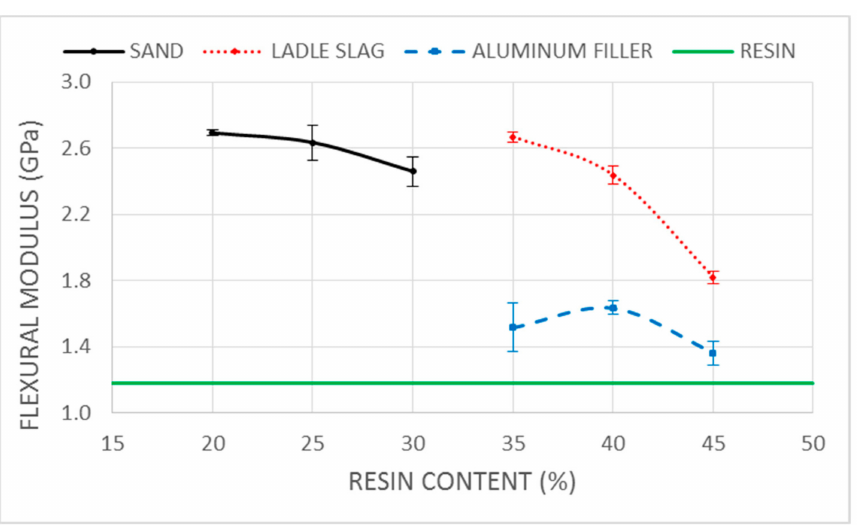
Figure 5. PPC flexural strength.